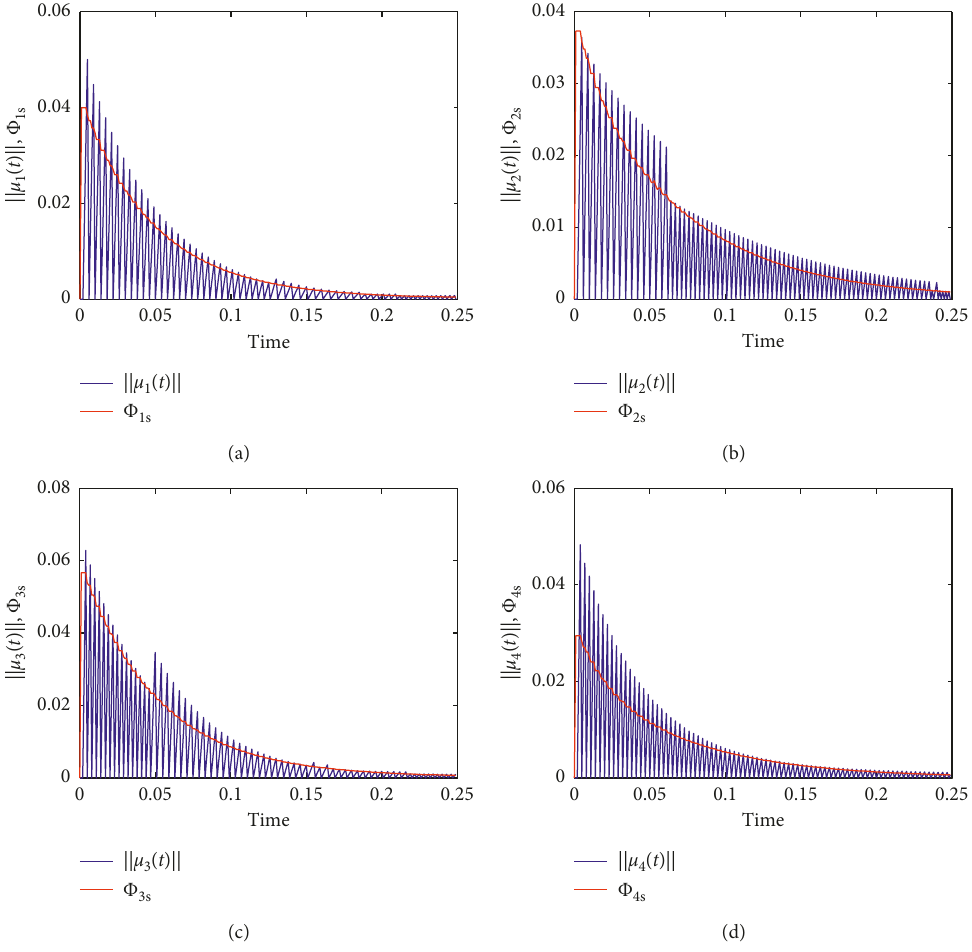
Figure 2: Time evolutions of measurement errors μ